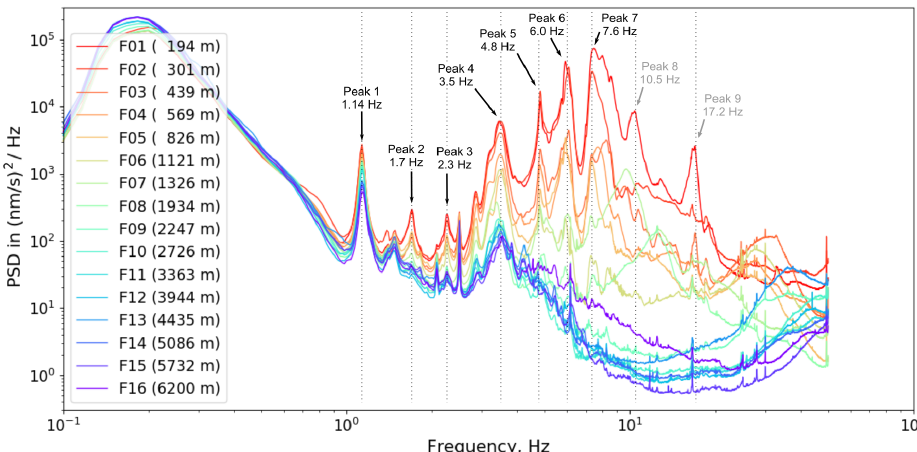
Figure 2. Average PSD spectra at full power status (11–12rpm), calculated at profile stations F01 to F16 in the time range from September 2019 to March 2020. The distance of each station to the WT is color coded and indicated in the figure legend. In total, nine energy peaks are identified between 1.14 and 17.2Hz, all of which show a systematic amplitude decrease with increasing station distance. The amplitude decays of peaks 1 to 7 have been measured and fitted by a power law.